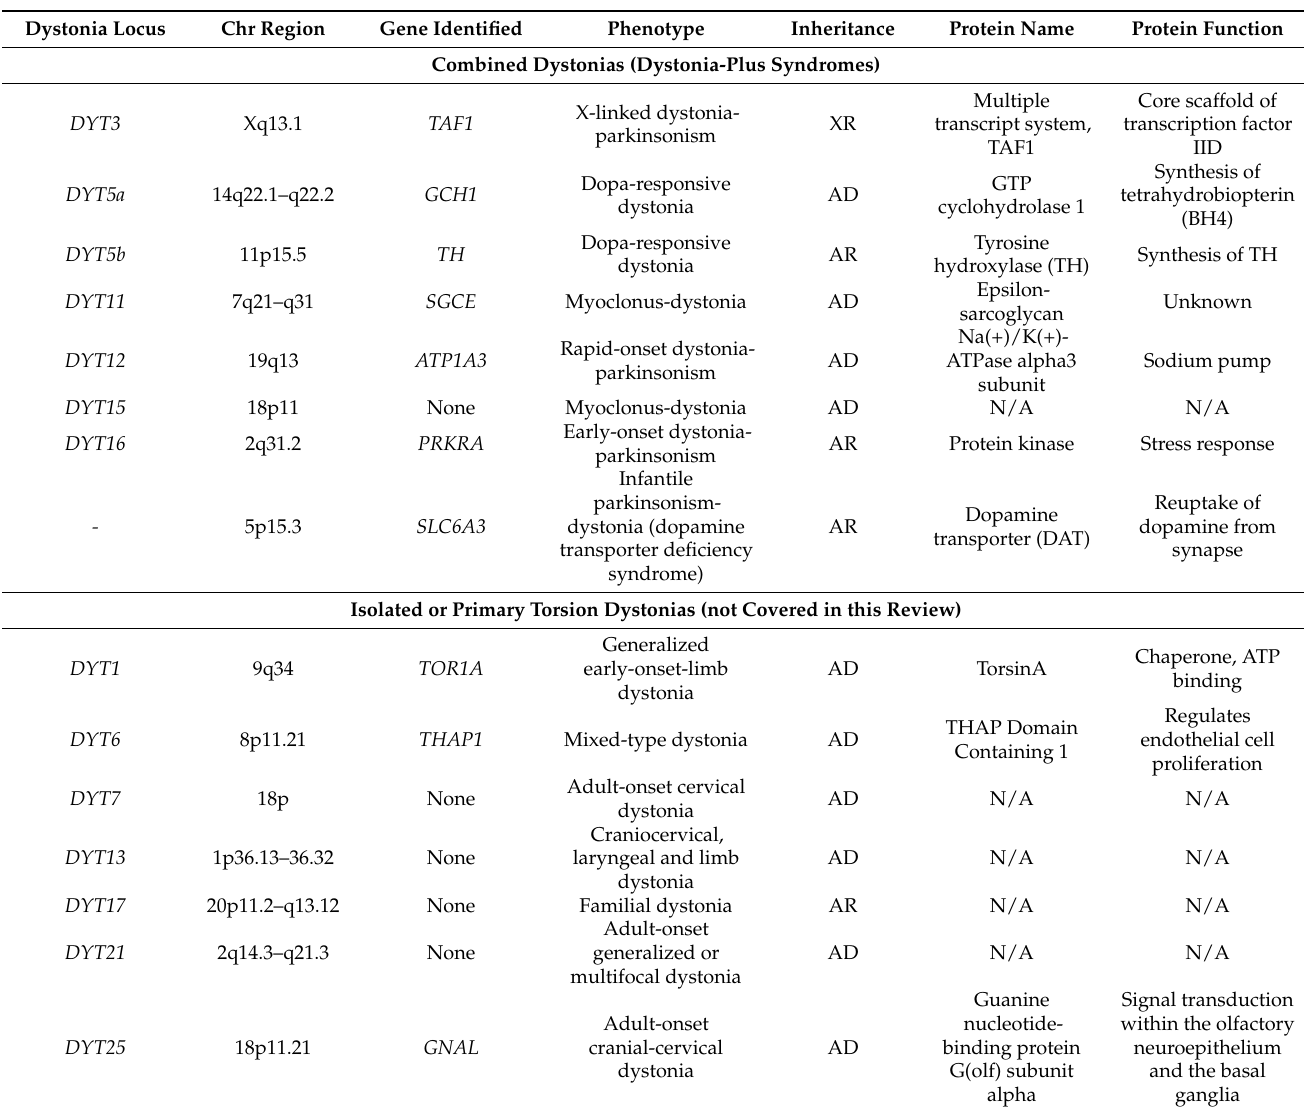
Table 1. Genetics of